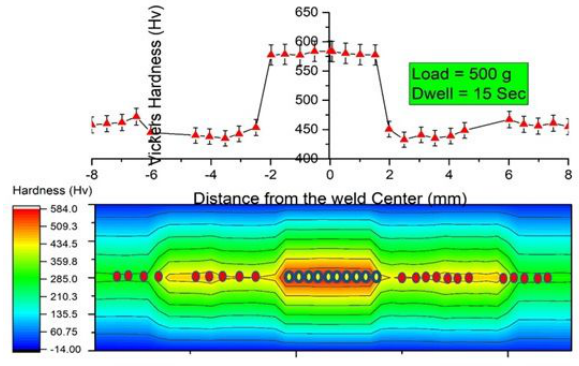
Figure 7: Microhardness mapping of weld nugget from the